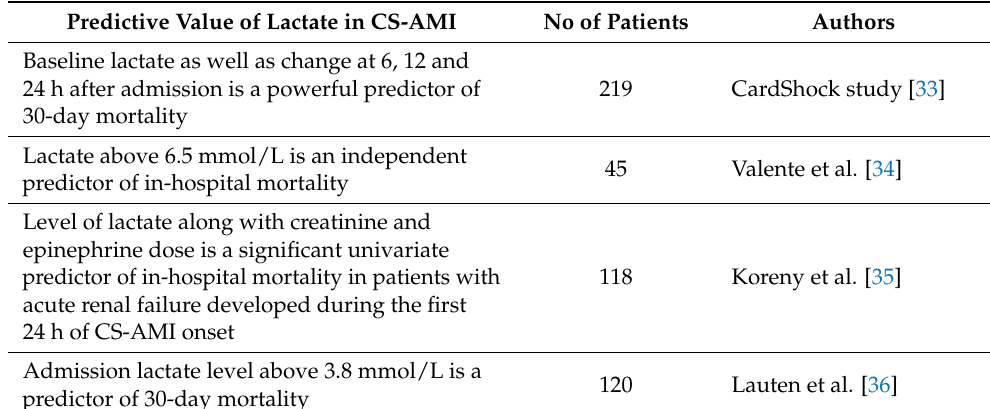
Table 3. Lactate blood concentration in prediction of developing cardiogenic shock in patients with myocardial